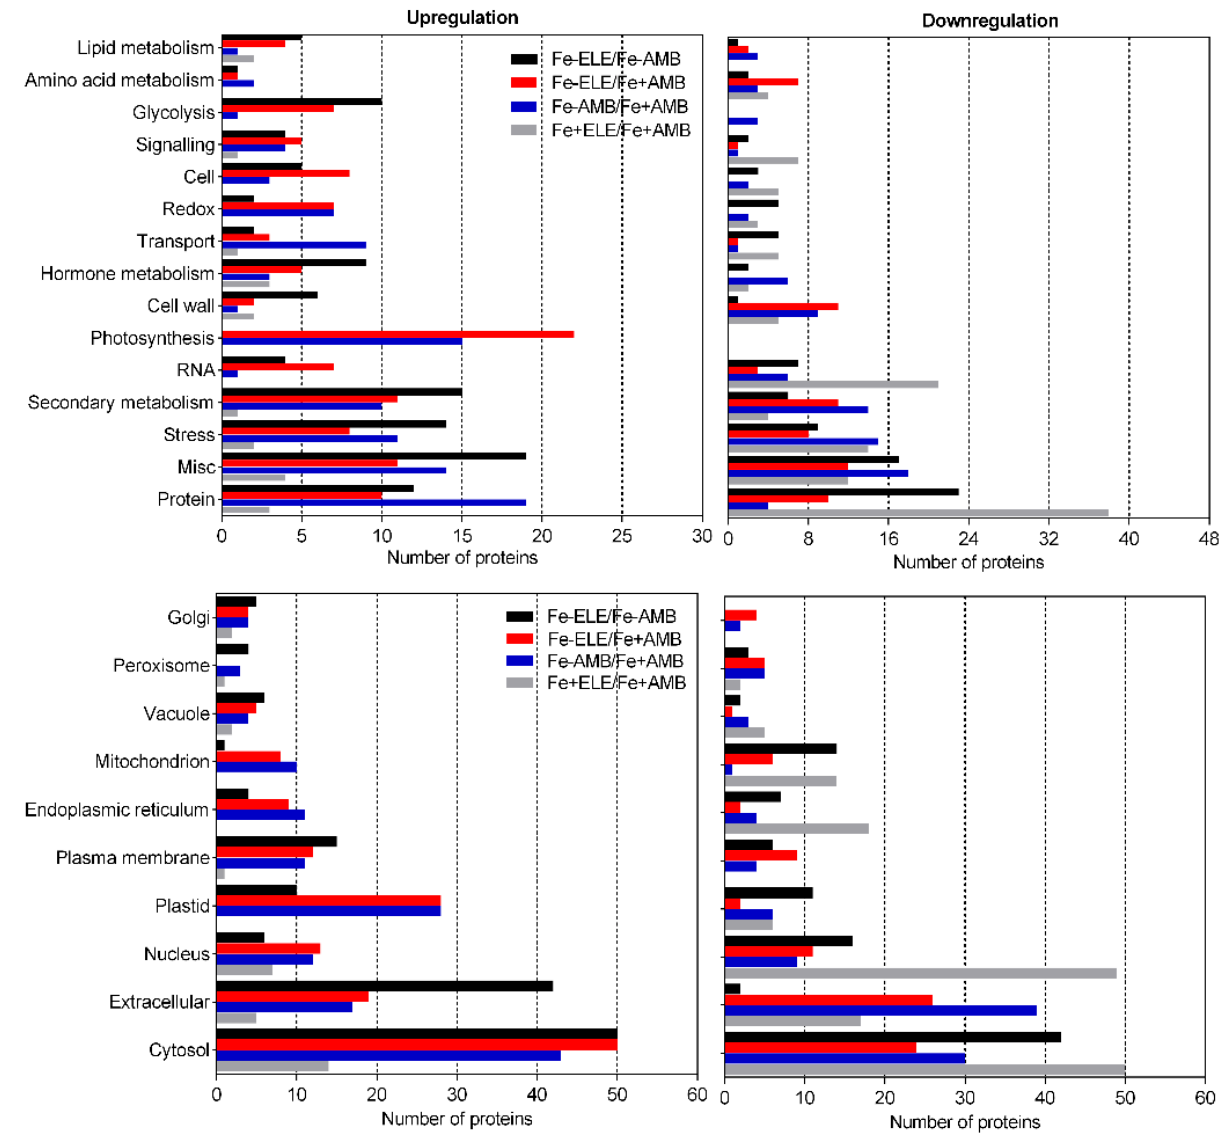
Figure 3. Numbers of DEPs identified from soybean roots at different CO 2 levels under sufficient and limited Fe-supply according to functional categories and subcellular compartments by MapMan. Fe+AMB, Fe-sufficient + aCO 2 ; Fe+ELE, Fe-sufficient + eCO 2 ; Fe-AMB, Fe-limitation + aCO 2 ; Fe-ELE, Fe-limitation + eCO 2 .